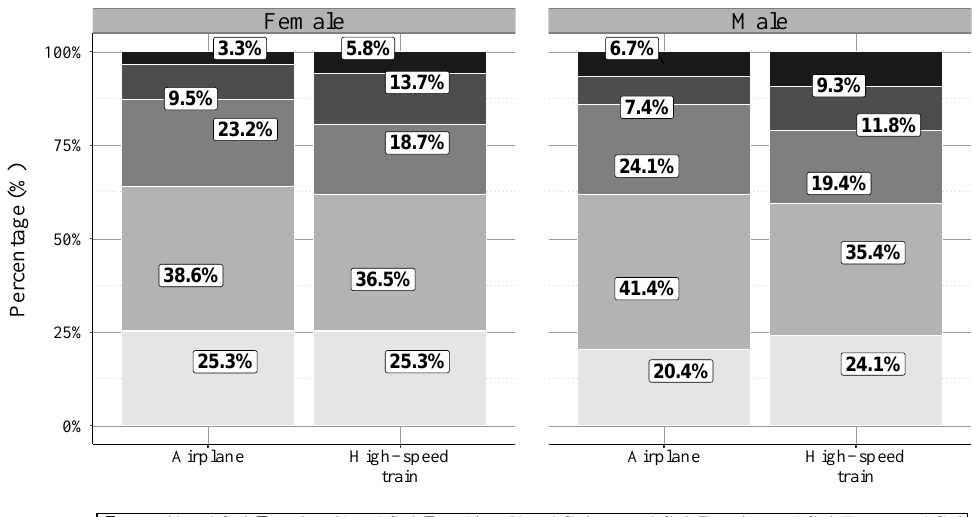
Figure 4. Respondents’ current level satisfaction with airplanes (flights) and high-speed trains by